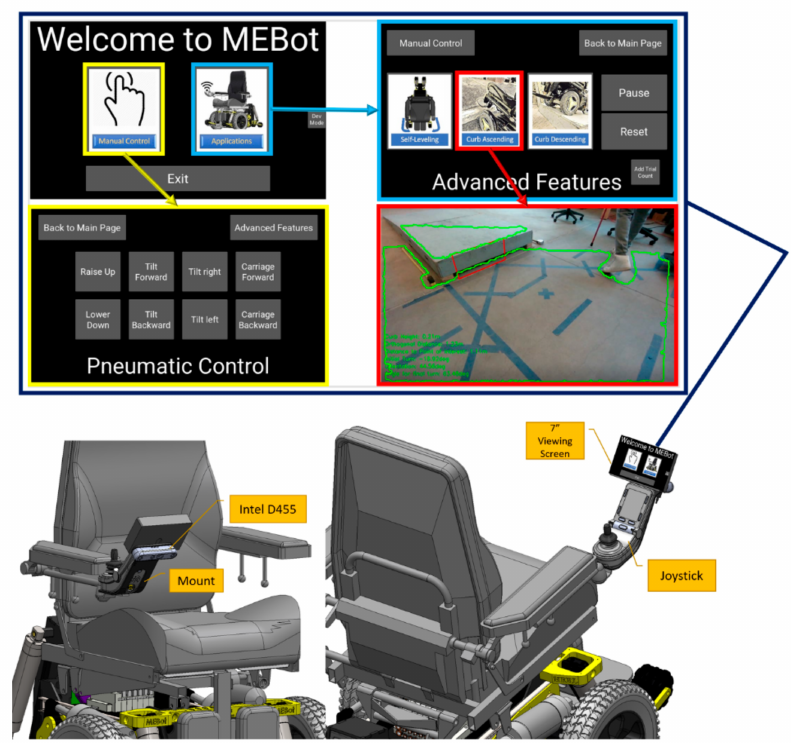
Figure 2. Intel RealSense mounts onto the wheelchair joystick and graphical user interface.